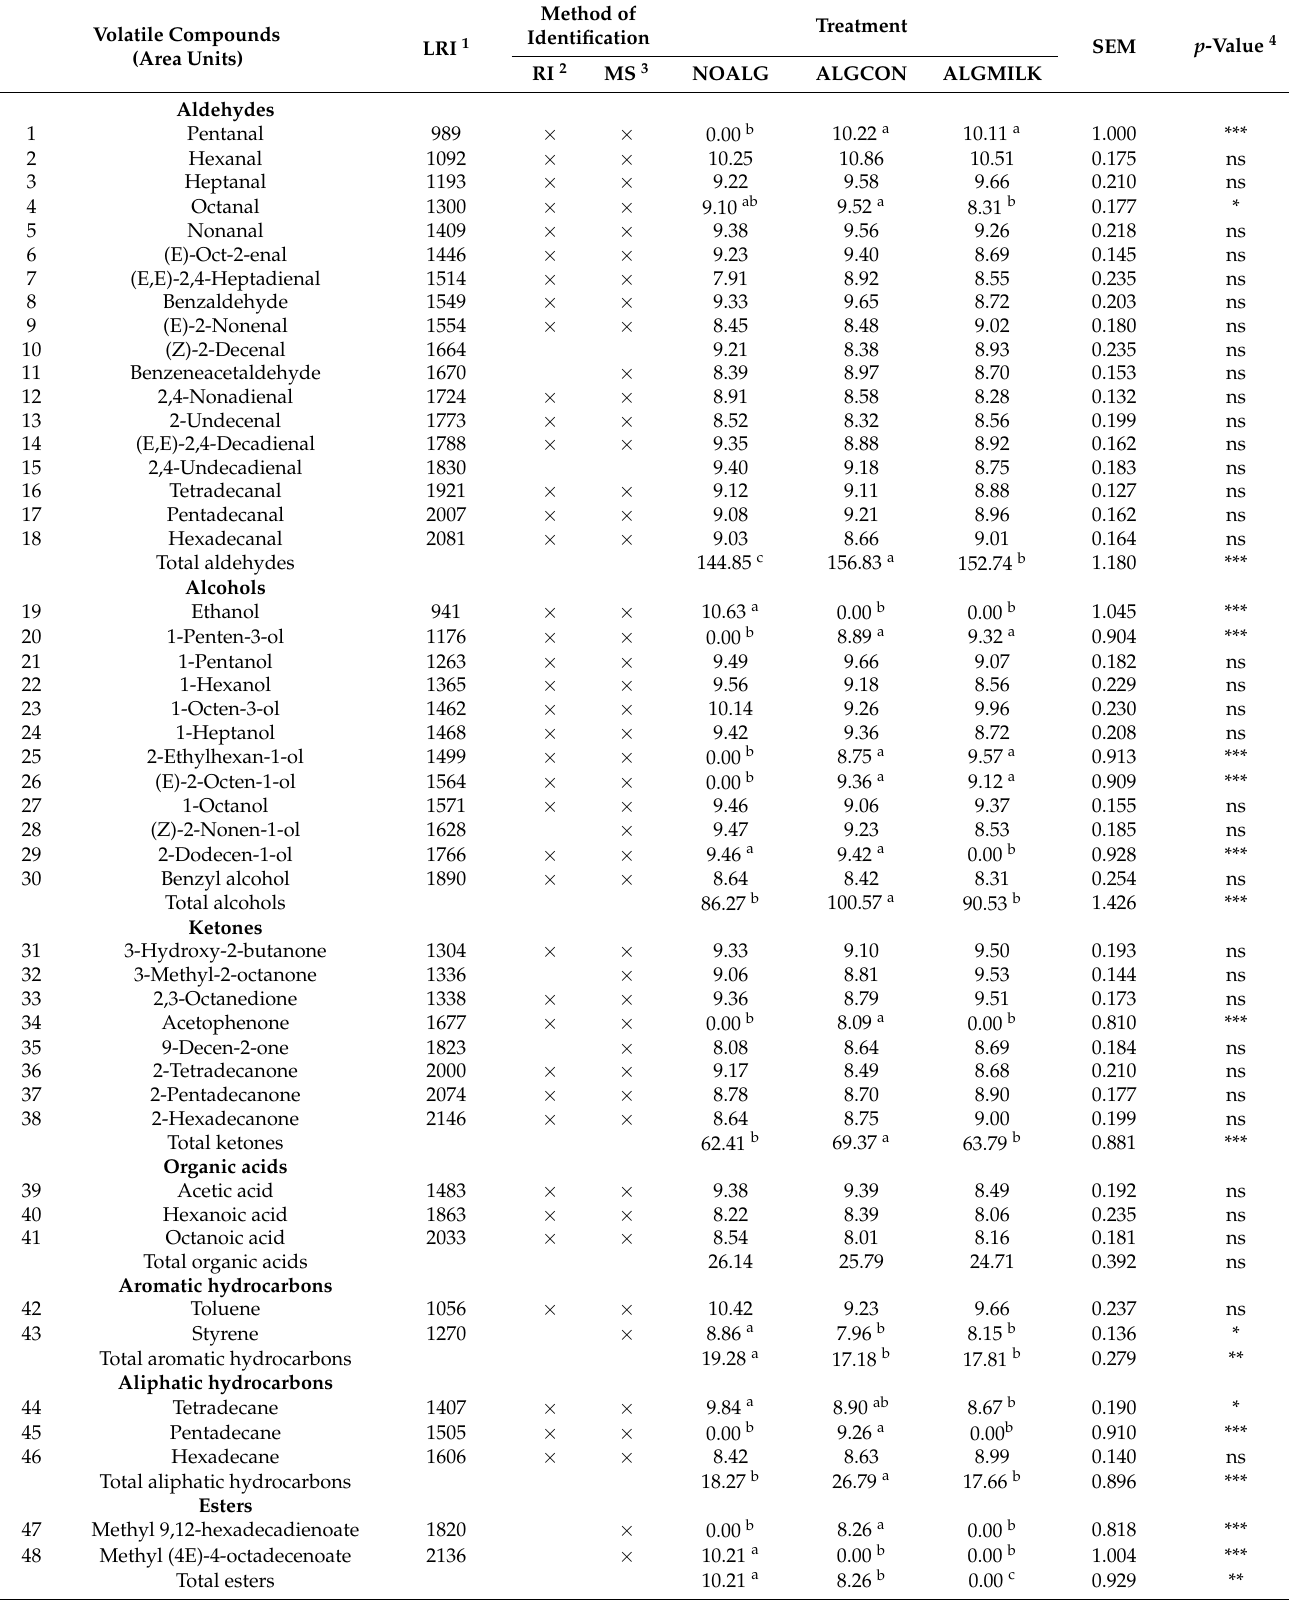
Table 2. Volatile profile of grilled meat from lambs fed a control diet (NOALG) and lambs with competent reticular groove reflex fed the control diet supplemented with 2.5% of marine algae meal mixed in the concentrate (ALGCON) or in a milk replacer